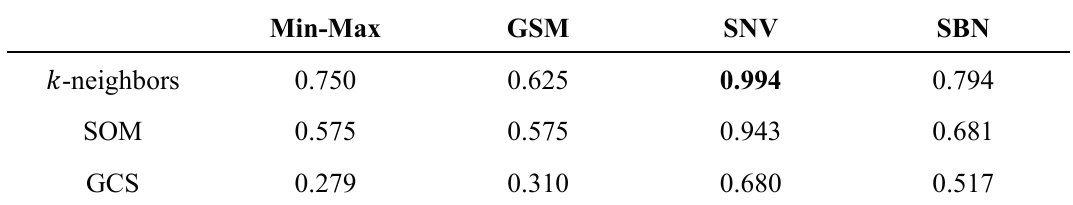
Table 11. Kappa indices obtained with the three classification techniques and the four normalization methods when denoising with the weighted moving average (WMA) method ( Gaussian window with (cid:2026) ). (cid:2870)